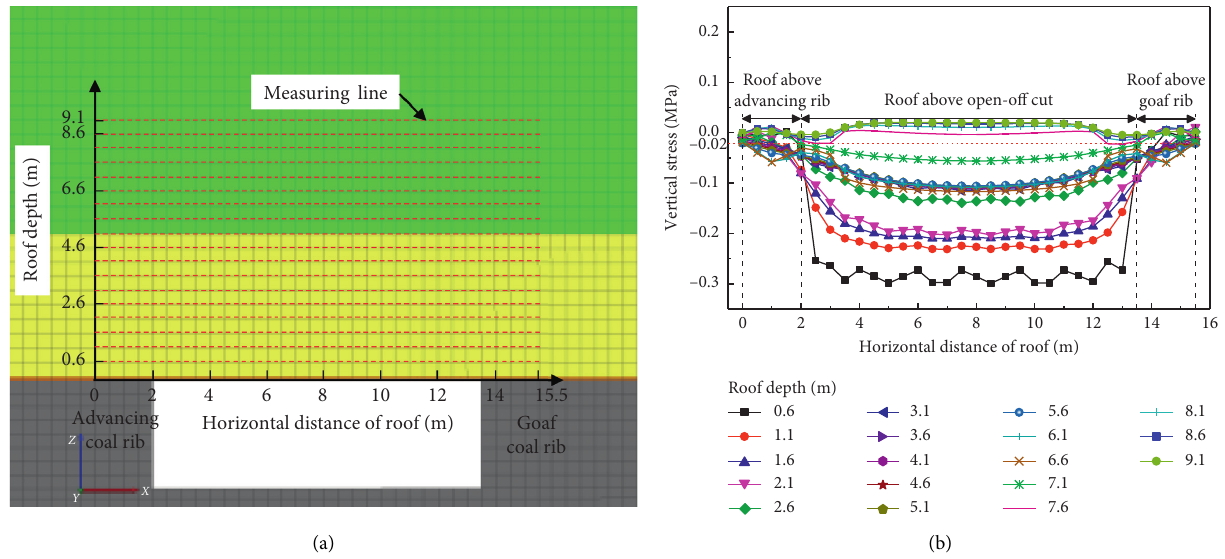
Figure 5: Prestressed stress distribution at different horizontal distances of the roof with varying depths. (a) Layout of measuring lines in Figure 4(a). (b) Prestressed stress distribution curves.